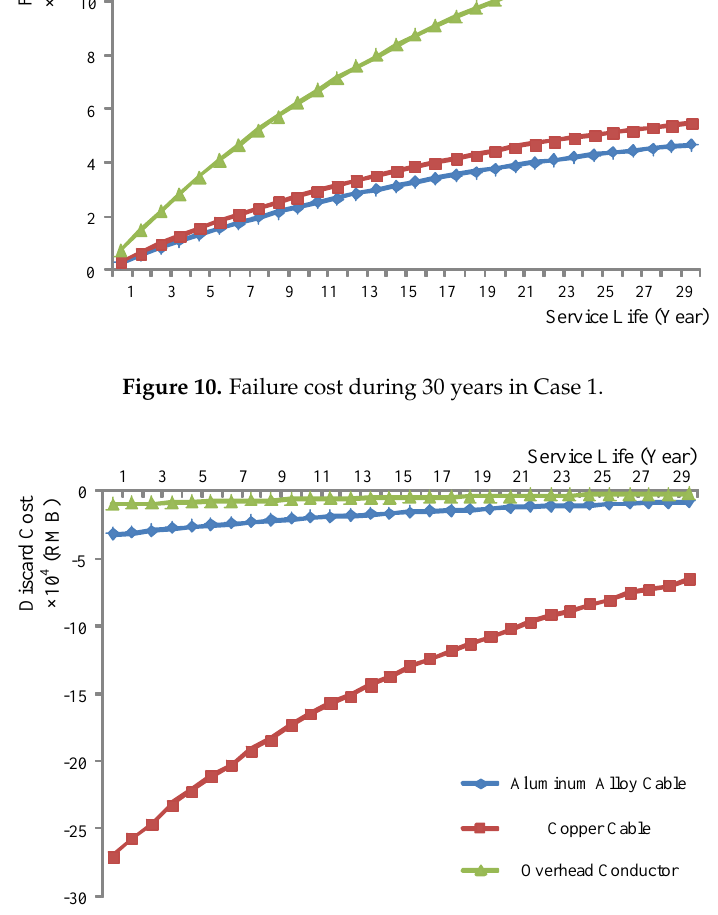
Figure 11. Discard cost during 30 years in Case